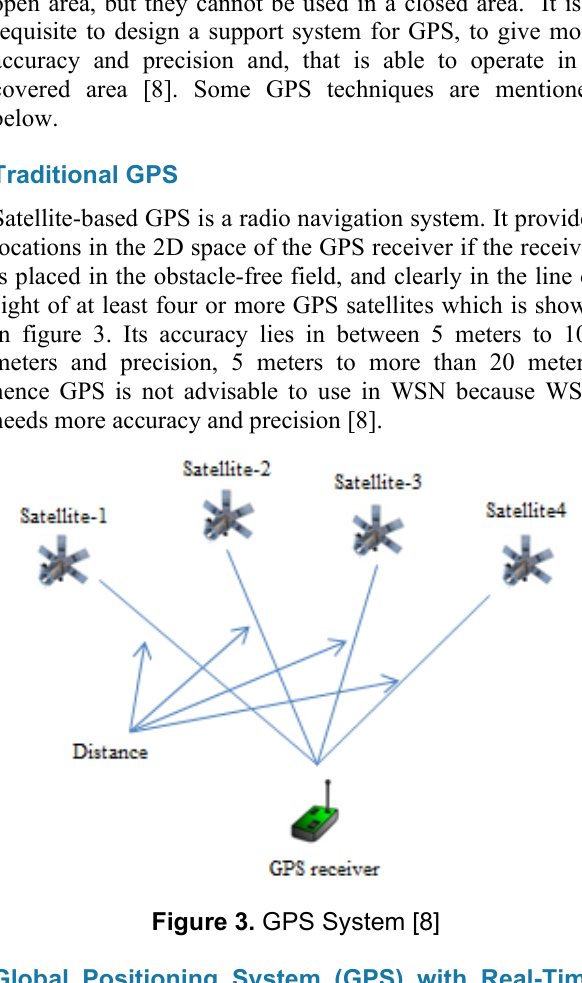
Global Positioning System (GPS) with Real-Time Kinematic